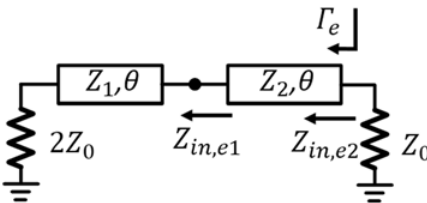
Figure 2. Bisected network with open ‐ circuit bisecting plane at the plane of symmetry for even ‐ mode analysis.